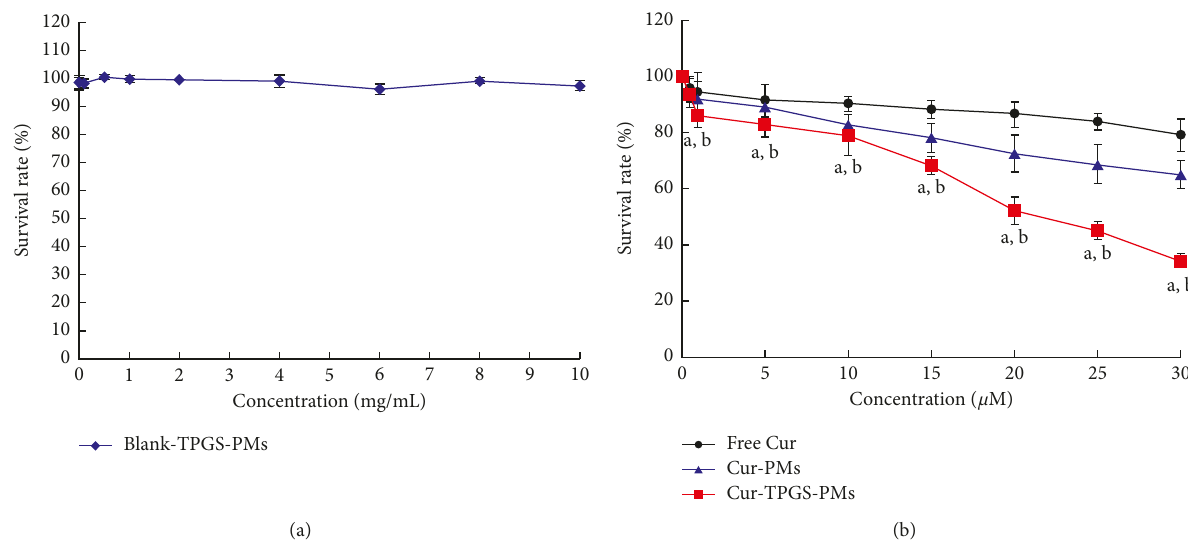
Figure 8: Survival rates of MCF-7 cells after treating with varying formulations. Data are presented as mean